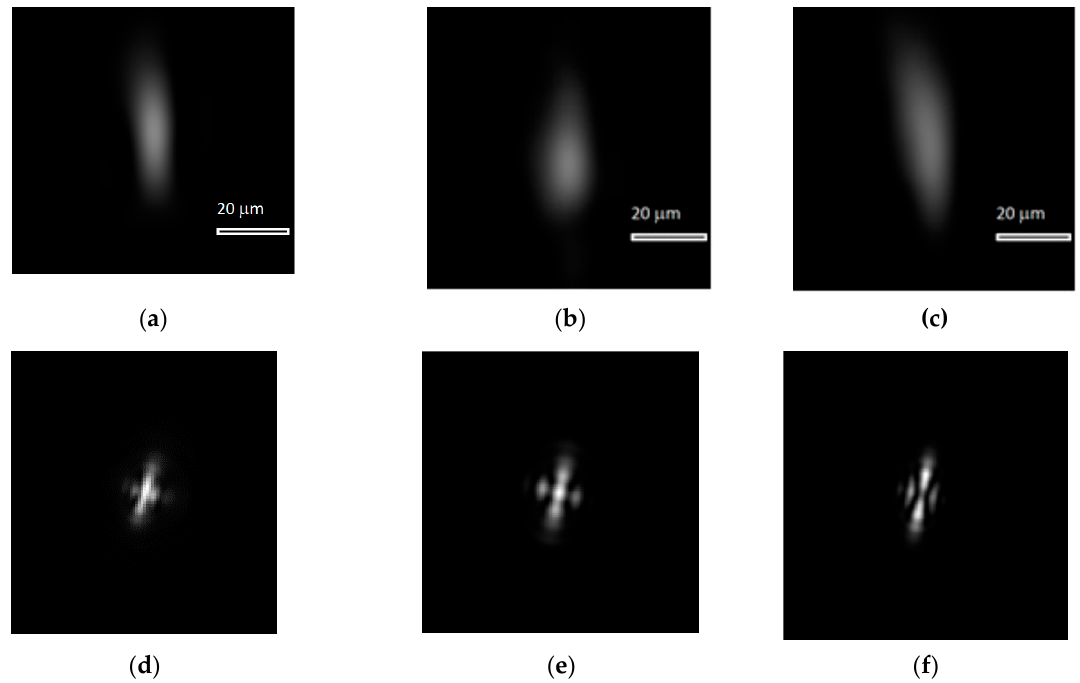
Figure 8. Experimentally derived point spread functions (PSFs) (interpolated using 5.5 × 5.5 µm pixels) at ( a ) 20 °C, ( b ) 40 °C, and ( c ) 12 °C, and ( d – f ) PSFs numerically calculated in the Zemax program for the same temperatures Table 3. Shift values for mirror and spherical di ff raction grating at di ff erent